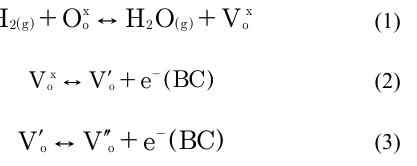
O in the presence of (a) H 2 3